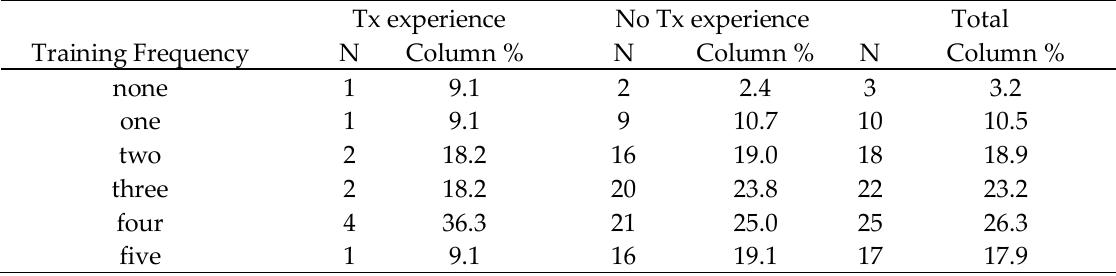
Table 3. Attendance of Volunteer Training Sessions for European Transplant Sports Week Tx experience No Tx experience Total Training Frequency N Column % N Column % N Column % none 1